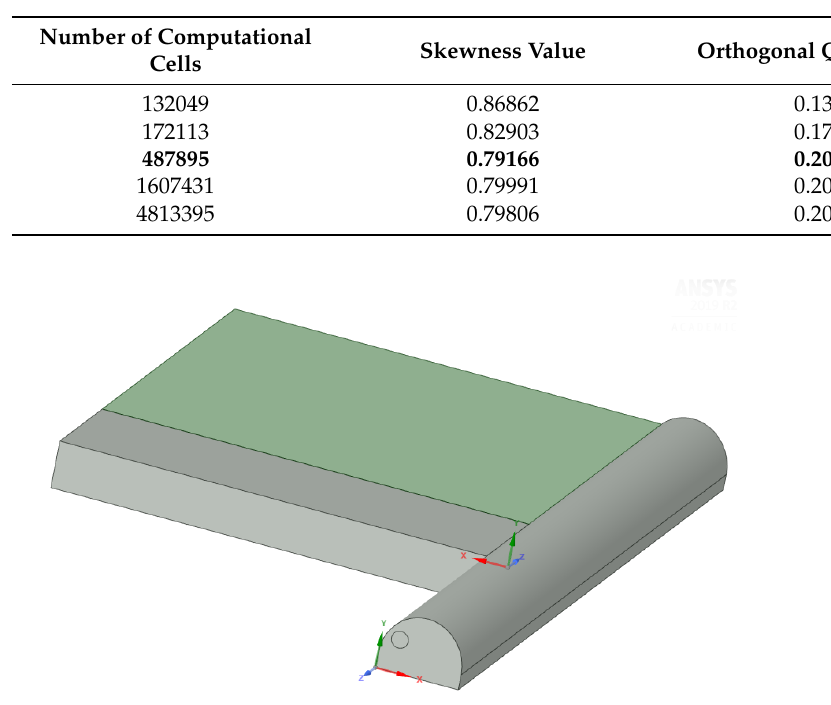
Table 1. Values of skewness and orthogonal quality parameters for different numbers of computa- tional cells.